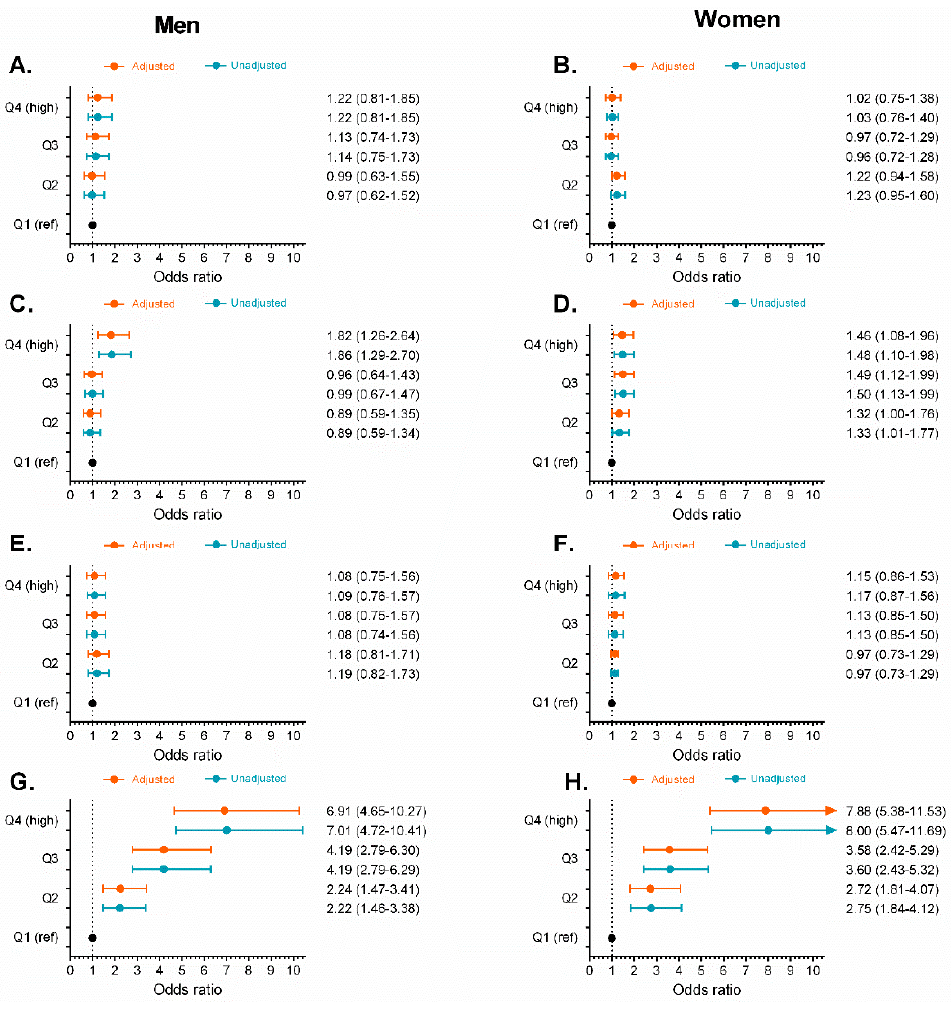
Figure 6. Unadjusted odds ratios ( ) and adjusted odds ratios ( ) for prediabetes in quartiles (Q) of obesity- and lipid-related indices by sex. ABSI Panel ( A,B ), C ( C,D ), VAI ( E,F ), and TyG ( G,H ) by sex. Odds ratio adjusted for age, smoking, drinking, and physical activity “proxy”. (Q1 reference “lowest” group), second quartile (Q2), third quartile (Q3), and fourth quartile (Q4 highest group).